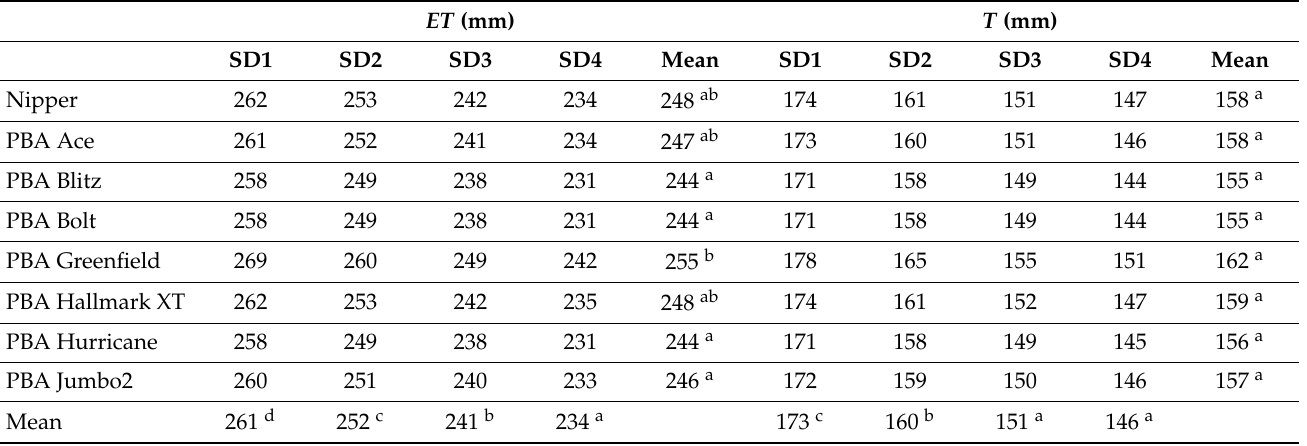
Table 6. Calculated values (mm) of evapotranspiration ( ET ) and transpiration ( T ) from the fitted linear mixed models. Different letters indicate significantly different values. The values for the genotypes at each sowing date (SD) are the means of three replicates. ET (mm) T